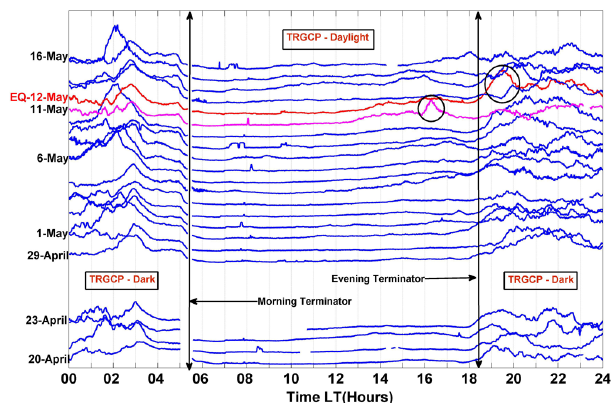
Fig. 2. Sequential plot of 24h amplitude data of JJI VLF transmitter, Japan, observed at Allahabad, India. Vertical arrows indicate morn- ing and evening terminator times. The circle on 11 and 12 May 2008 indicates unusual increase in the VLF